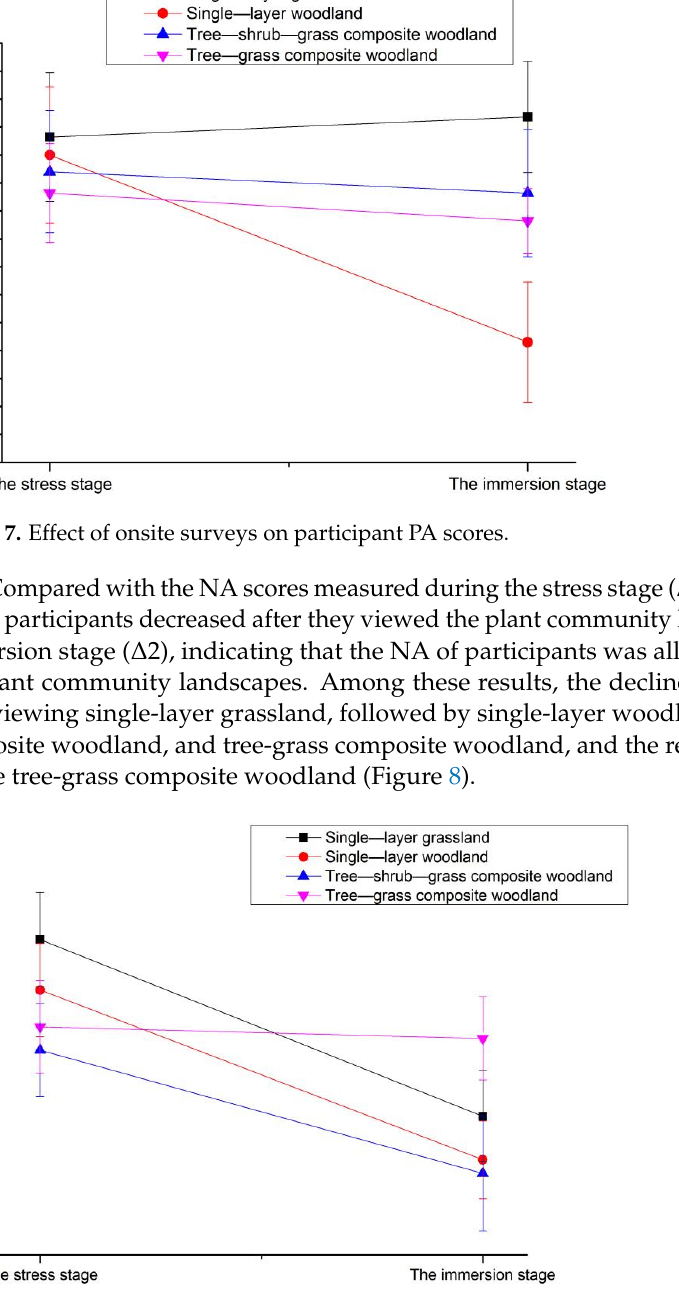
Figure 6. Effect of photo elicitation on the SCL indicators of the participants .